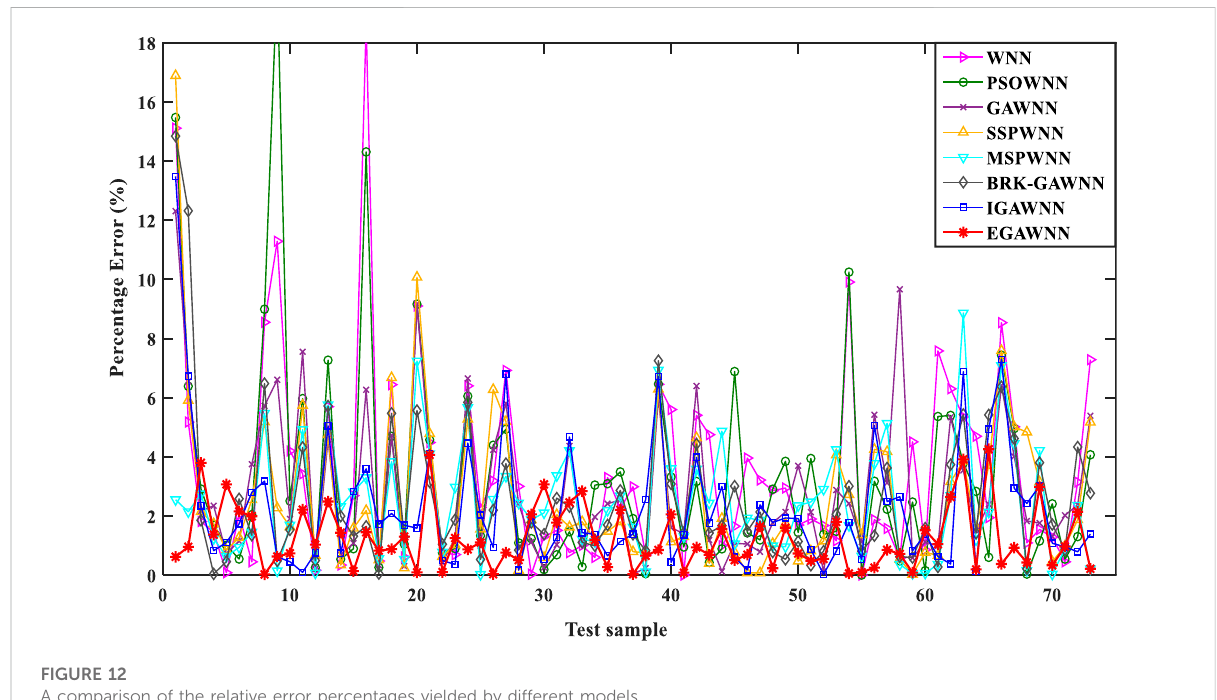
FIGURE 12 A comparison of the relative error percentages yielded by different models.